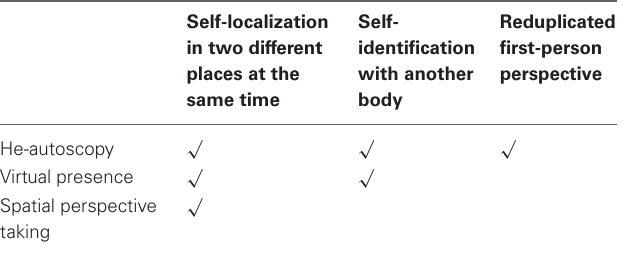
Table 1 | Instances of mental bilocation in which the three MPS components are differentially present.